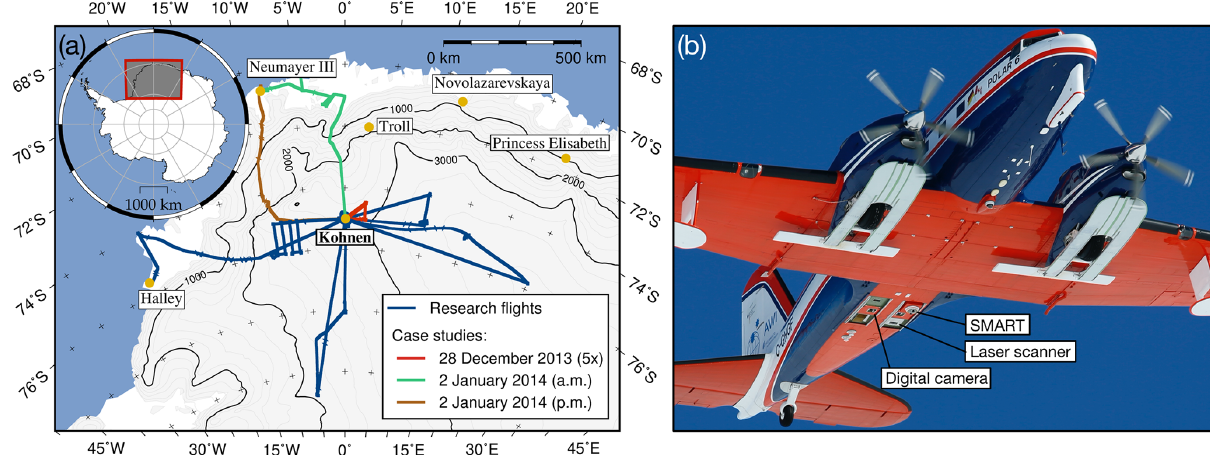
Figure 1. (a) Illustration of research flights with Polar 6 in Dronning Maud Land between 24 December 2013 and 5 January 2014. The five flights on 28 December 2013 (marked in red) and the two flights on 2 January 2014 (green and brown) are used for the case studies. The parameter ranges covered by the case studies are marked with the same colors within the histograms in Fig. 2. (b) Photograph of Polar 6 illustrating the mounting of the digital camera, SMART, and the laser scanner.